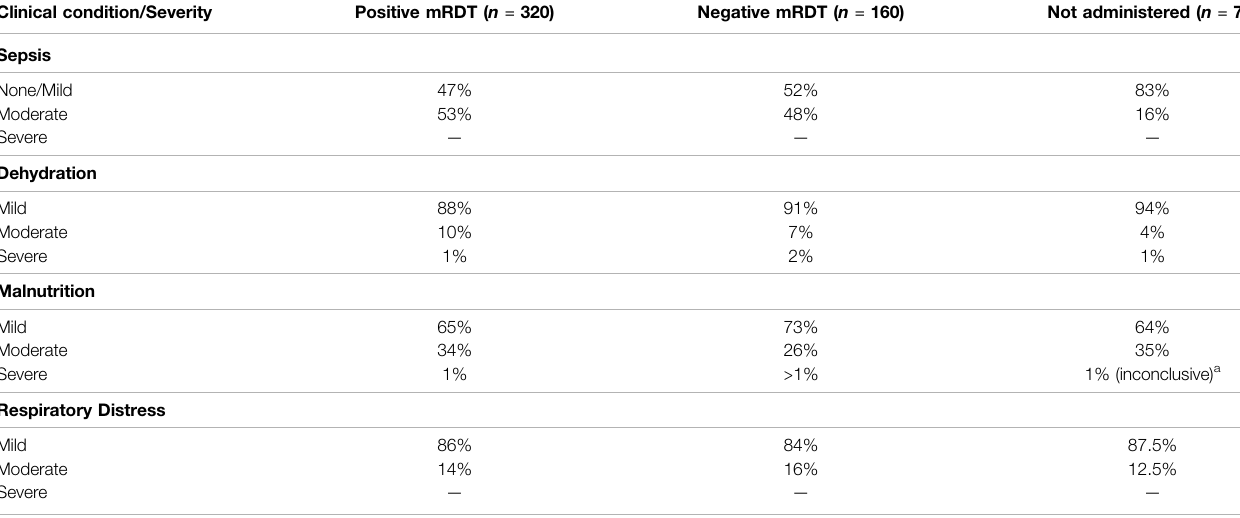
TABLE 4 | Distribution of clinical conditions and severity variables identi fi ed by THINKMD ’ s malaria risk algorithm compared to mRDT fi ndings. Clinical condition/Severity